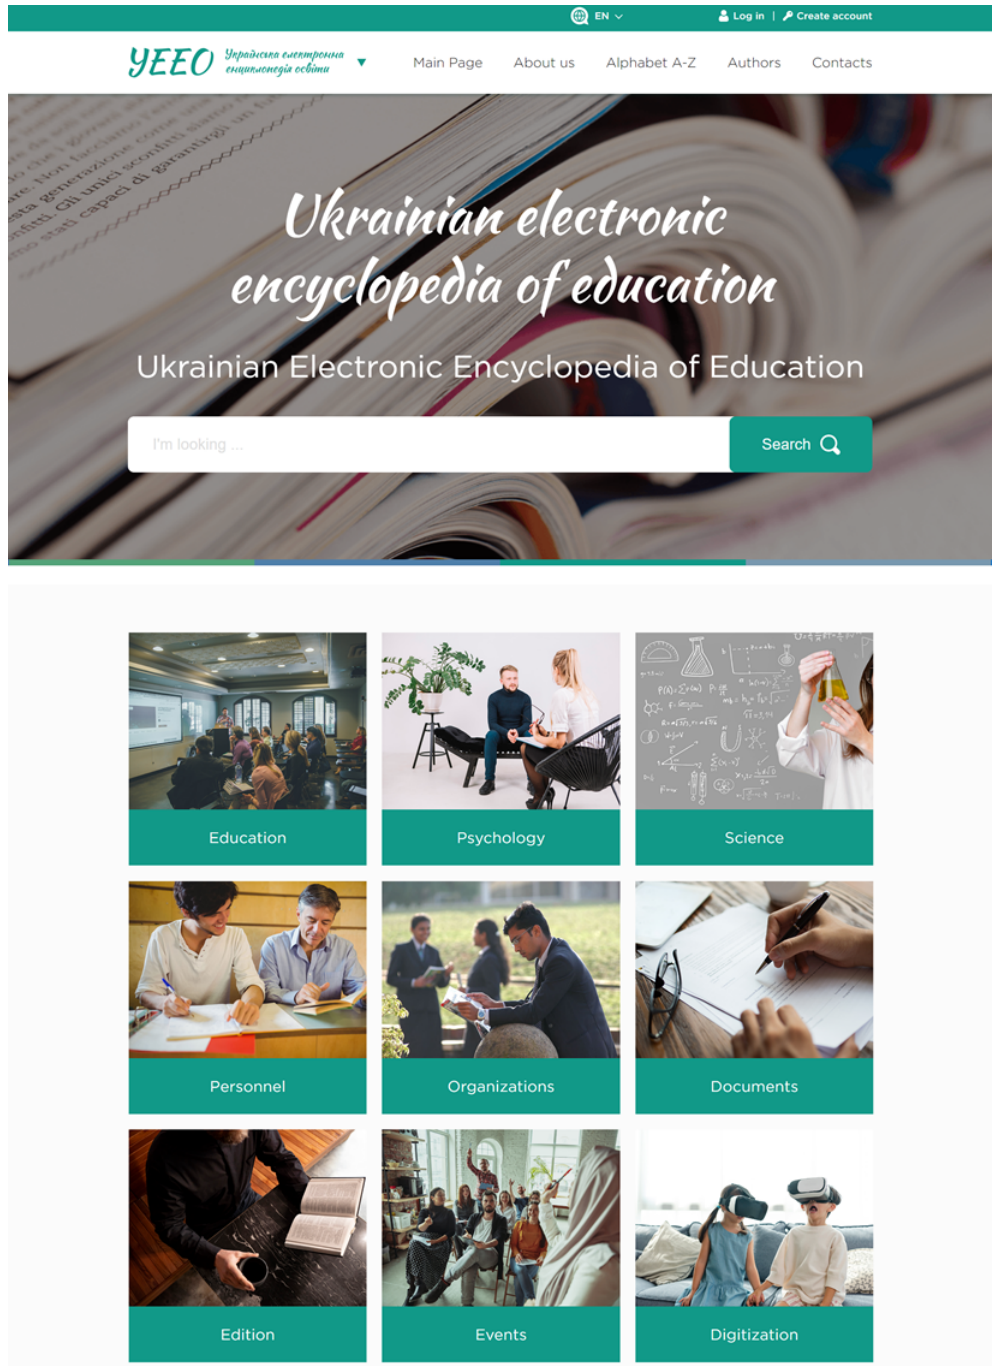
Figure 3: The homepage of the Ukrainian Electronic Encyclopedia of Education